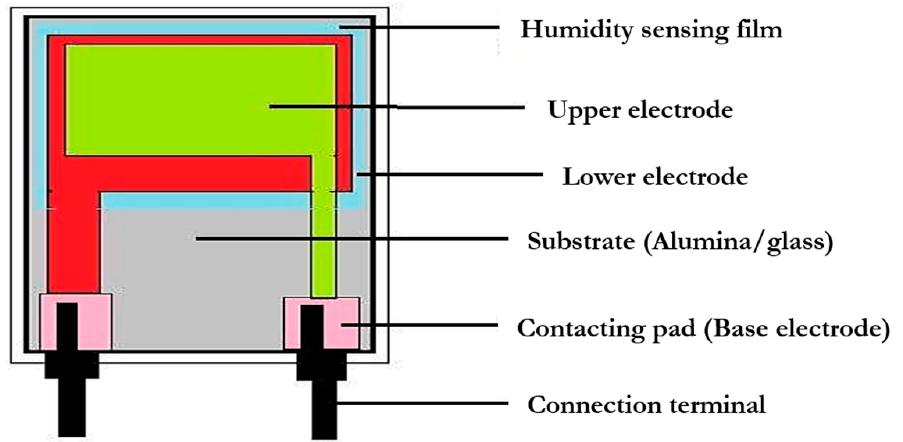
Figure 6. Configuration of a capacitive humidity sensor.